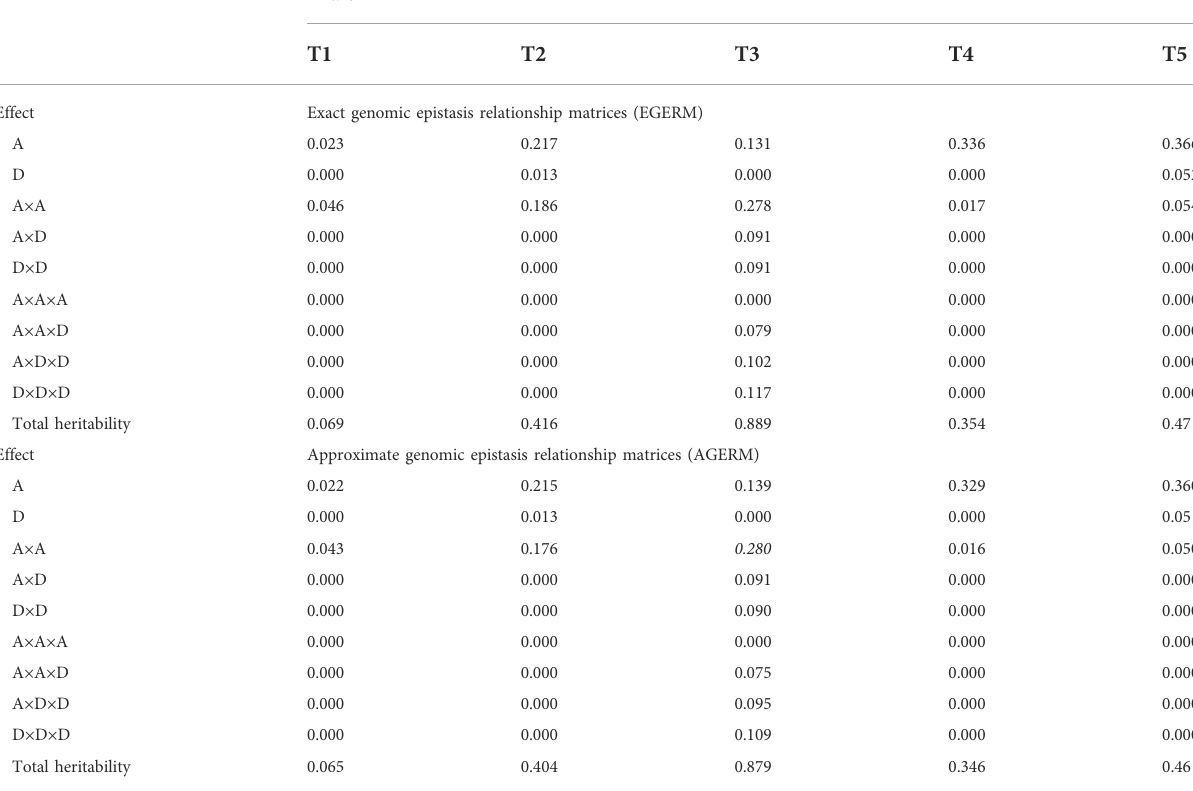
TABLE 1 Genomic heritability estimates of additive, dominance, and epistasis effects up to the third-order for fi ve traits in a swine population.